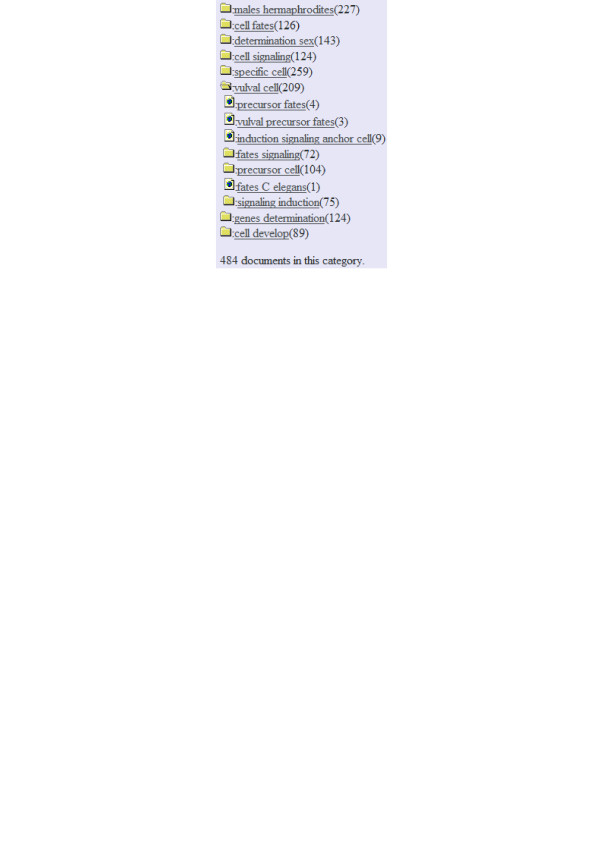
An example of the clustering results from the Sex Determination category. An intuitive interface allows users to quickly locate the topic of interest. The topics listed were generated automatically during the phrase-based clustering step.